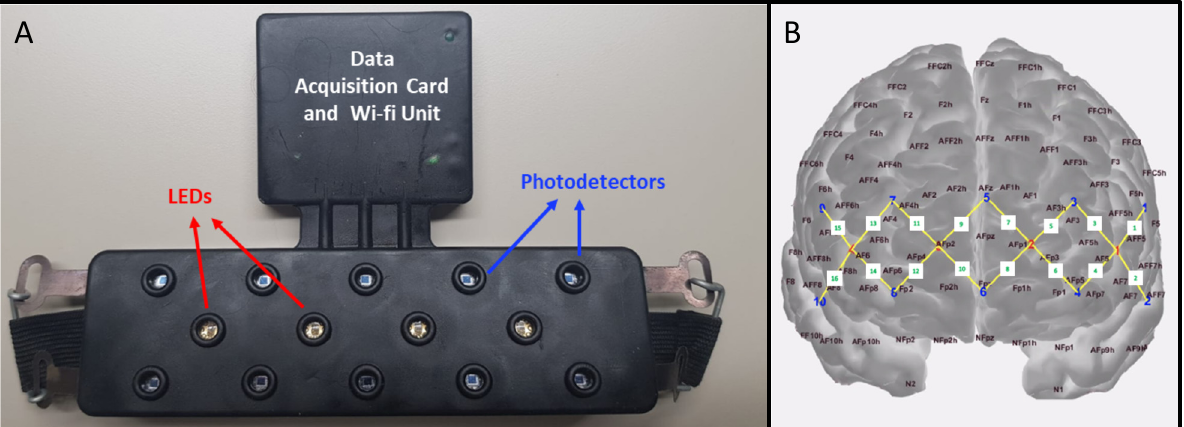
Figure 3. ( A ) Configuration of the forehead probe and ( B ) approximate location of the LEDs and photodetectors with respect to the international 10–20 system for electrode placement. LEDs are demonstrated with red dots and detectors are represented with blue dots. Yellow lines are drawn between the LED–photodetector pairs, which form a total of 16 channels.